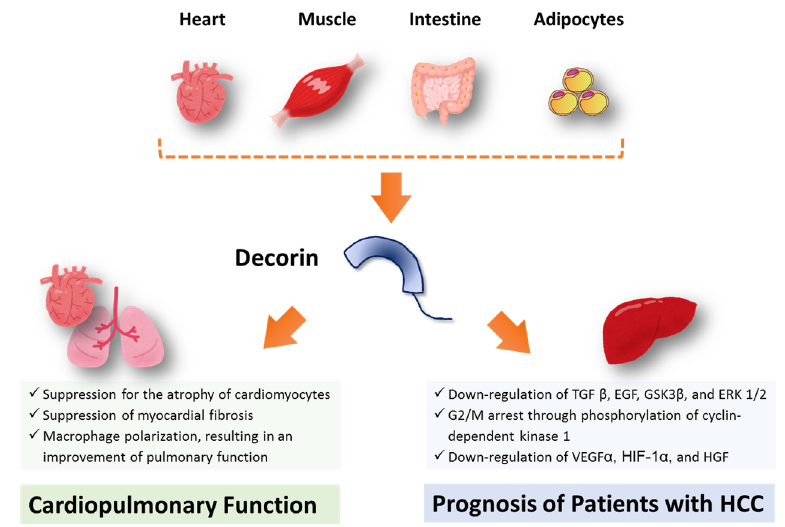
Figure 3. A scheme for the proposed hypothesis of this study. Decorin is expressed in various tissues including skeletal muscle, heart, intestine, and adipocytes. In this study, it remains unclear where decorin comes from. Decorin may be associated with cardiopulmonary function, because decorin suppresses the atrophy of cardiomyocytes, myocardial fibrosis, and causes macrophage polarization. In addition, decorin may be associated with prognosis of patients with HCC, because decorin downregulates transforming growth factor- β 1, epidermal growth factor receptor, glycogen synthase kinase 3 β , and extracellular signal-regulated kinase 1 / 2, G2 / M arrest through phosphorylation of cyclin-dependent kinase 1, downregulation of vascular endothelial growth factor A, hypoxia-inducible factor 1- α , and hepatocyte growth factor. Abbreviations: TGF β , transforming growth factor- β 1; EGF, epidermal growth factor receptor; GSK3 β , glycogen synthase kinase 3 β ; and ERK, extracellular signal-regulated kinase; VEGF, vascular endothelial growth factor; HIF-1 α , hypoxia-inducible factor 1- α ; HGF, hepatocyte growth factor.